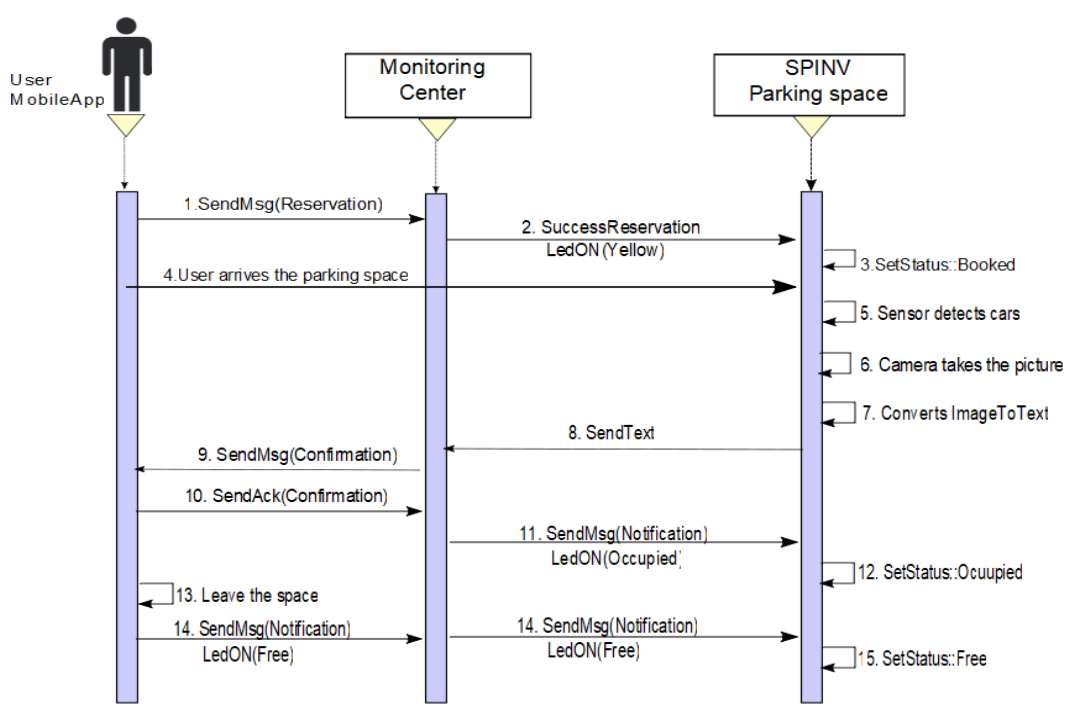
Figure 6. Sequence diagram of Scenario 1. Reserve/arrive to the booked parking